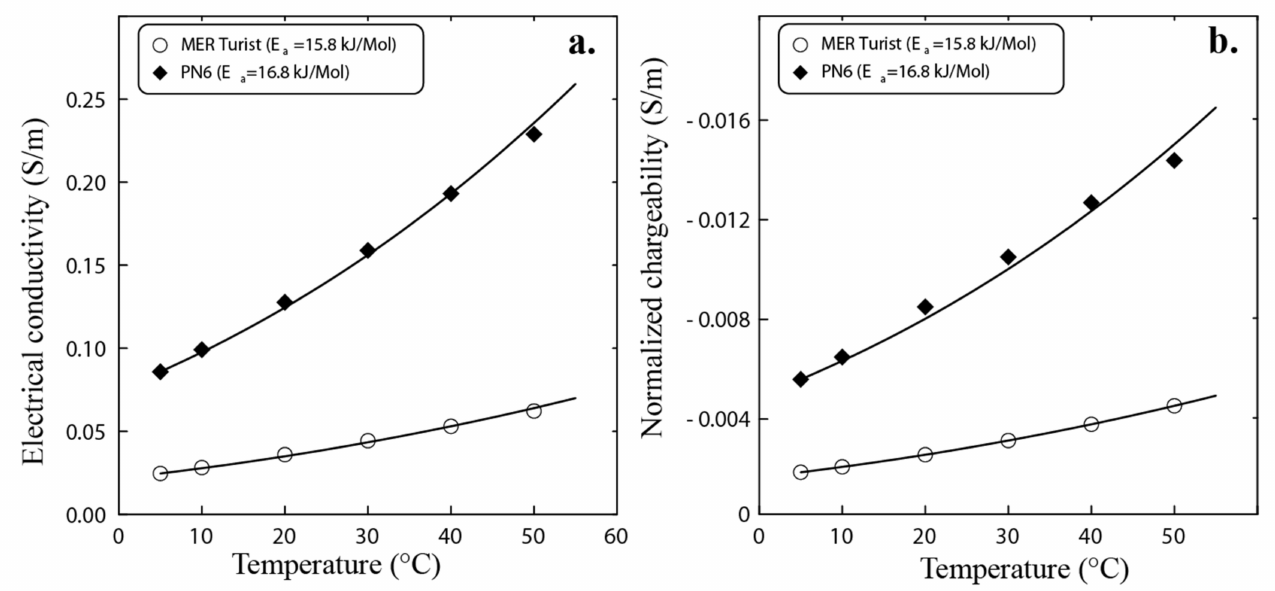
Figure 7. Influence of temperature upon the electrical conductivity and the normalized chargeability of two core samples from Merapi and Papandayan strato-volcanoes in Indonesia, respectively (data from Ghorbani et al. [38]). The data are obtained in the laboratory using an isothermal bath. ( a ) Electrical conductivity versus temperature for the two core samples. ( b ) Normalized chargeability versus temperature. The lines correspond to fits using an Arrhenius law (see main text). The fitted activation energies are close to the activation energy of the viscosity of the pore water (15–17 kJ Mol − 1 ). The direct effect of the temperature on the conductivity is roughly 2% per degree